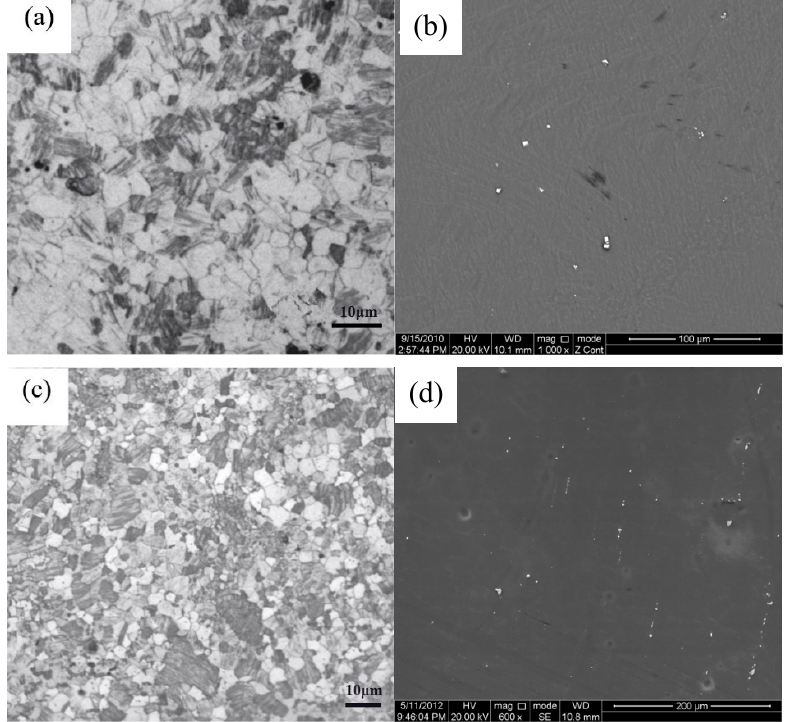
Figure 1. Microstructures of the forged alloy and extruded alloy. ( a , b ) optical microscope (OM) microstructure and scanning electron microscope (SEM) image of the forged alloy, ( c ) and ( d ) OM microstructure of the transverse section and SEM image of the extruded